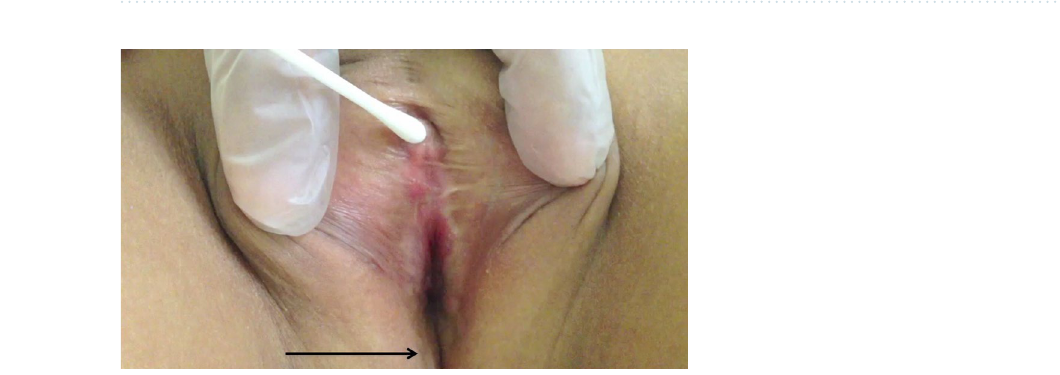
Figure 2. Flow chart of the study population. CAH congenital adrenal hyperplasia, CPR Clitoro-Perineal reflex, N number.